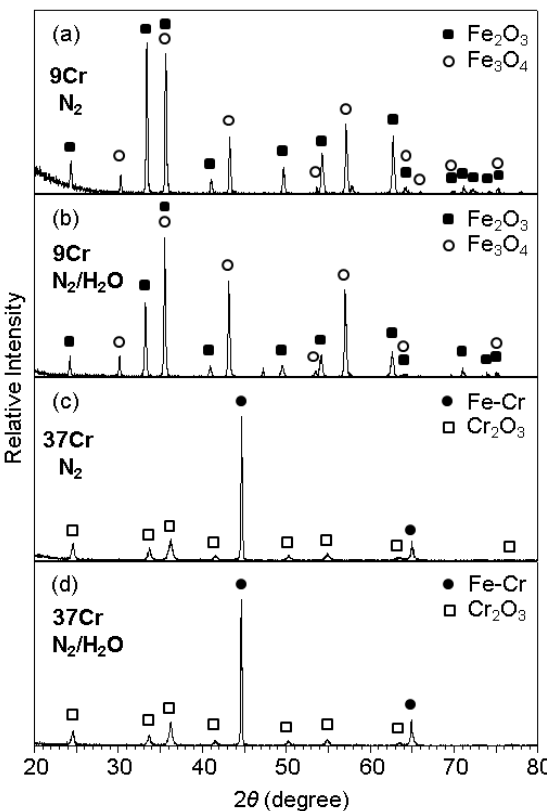
Figure 2. XRD patterns taken after corrosion testing at 800 °C for 70 h. ( a ) Fe-9Cr in N 2 ; ( b ) Fe-9Cr in N 2 /3.2%H 2 O; ( c ) Fe-37Cr in N 2 ; ( d ) Fe-37Cr in N 2 /3.2%H 2 O.